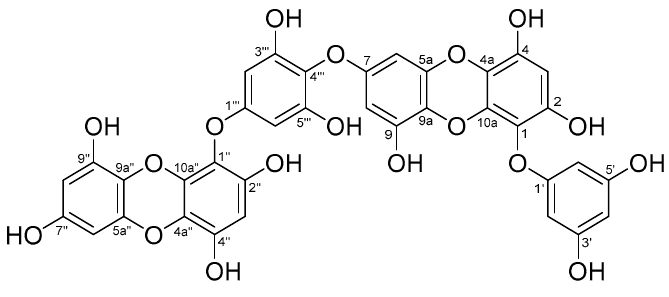
Figure 6. Chemical structure of compound 1 (dieckol).